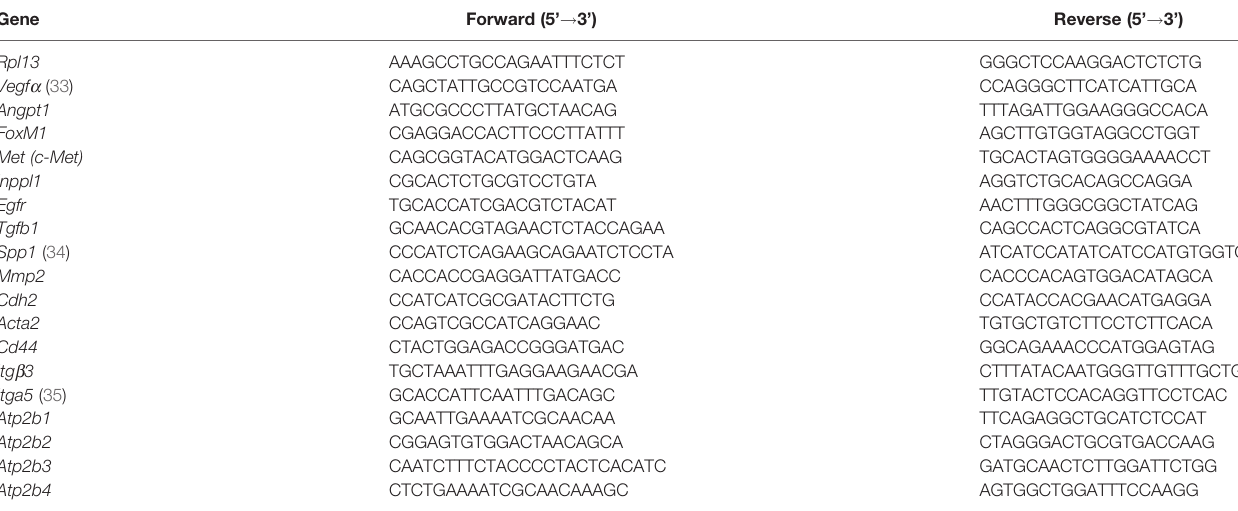
TABLE 1 | Primer sequences used for qPCR